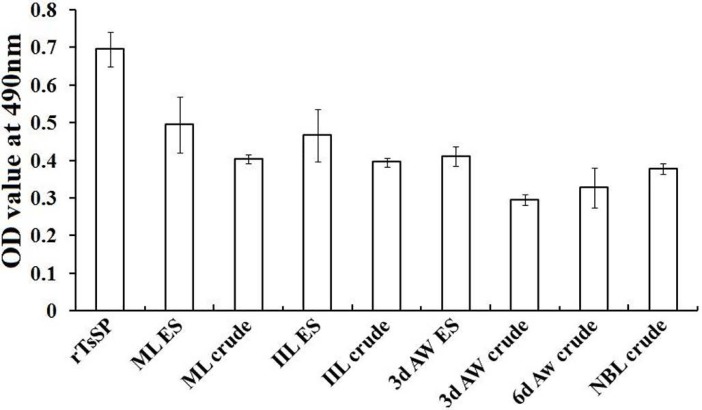
Anti-rTsSP IgG level of immunized mice determined by ELISA using antigens from various stages.OD values shown for each group (n = 13) were the arithmetic mean ± standard deviation (SD) of serum anti-rTsSP IgG levels.